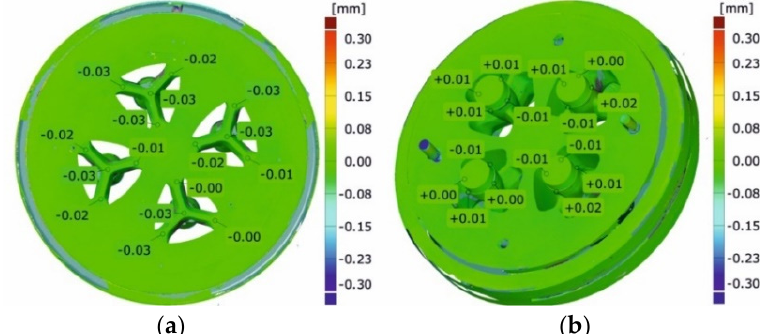
Figure 23. Results of optical scanning of the porthole dies for extrusion of tubes of Ø50 × 2 mm from 6082 alloy: die deflection—bridges view ( a ) and the mandrels ( b ).